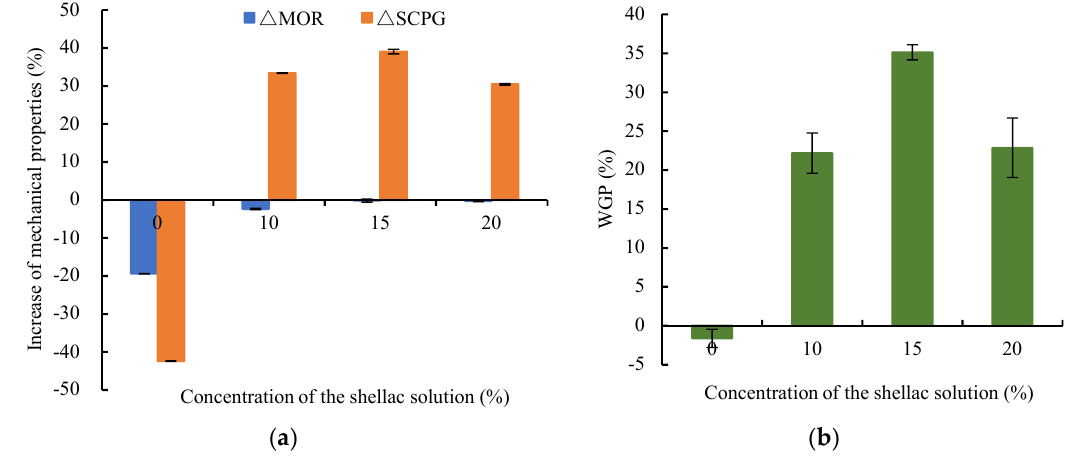
Figure 2. The mechanical strength and weight gain of wood samples impregnated with different concentrations: ( a ) increase in mechanical properties; ( b ) WGP.